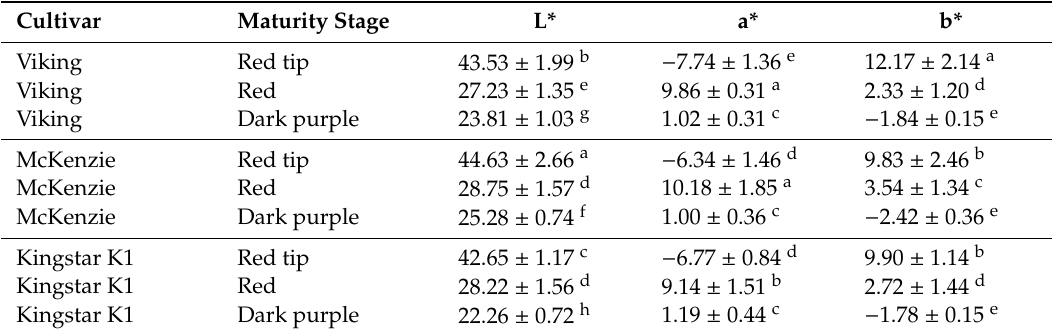
Table 1. Hunter L, a, b color of Aronia melanocarpa fruits at di ff erent maturity